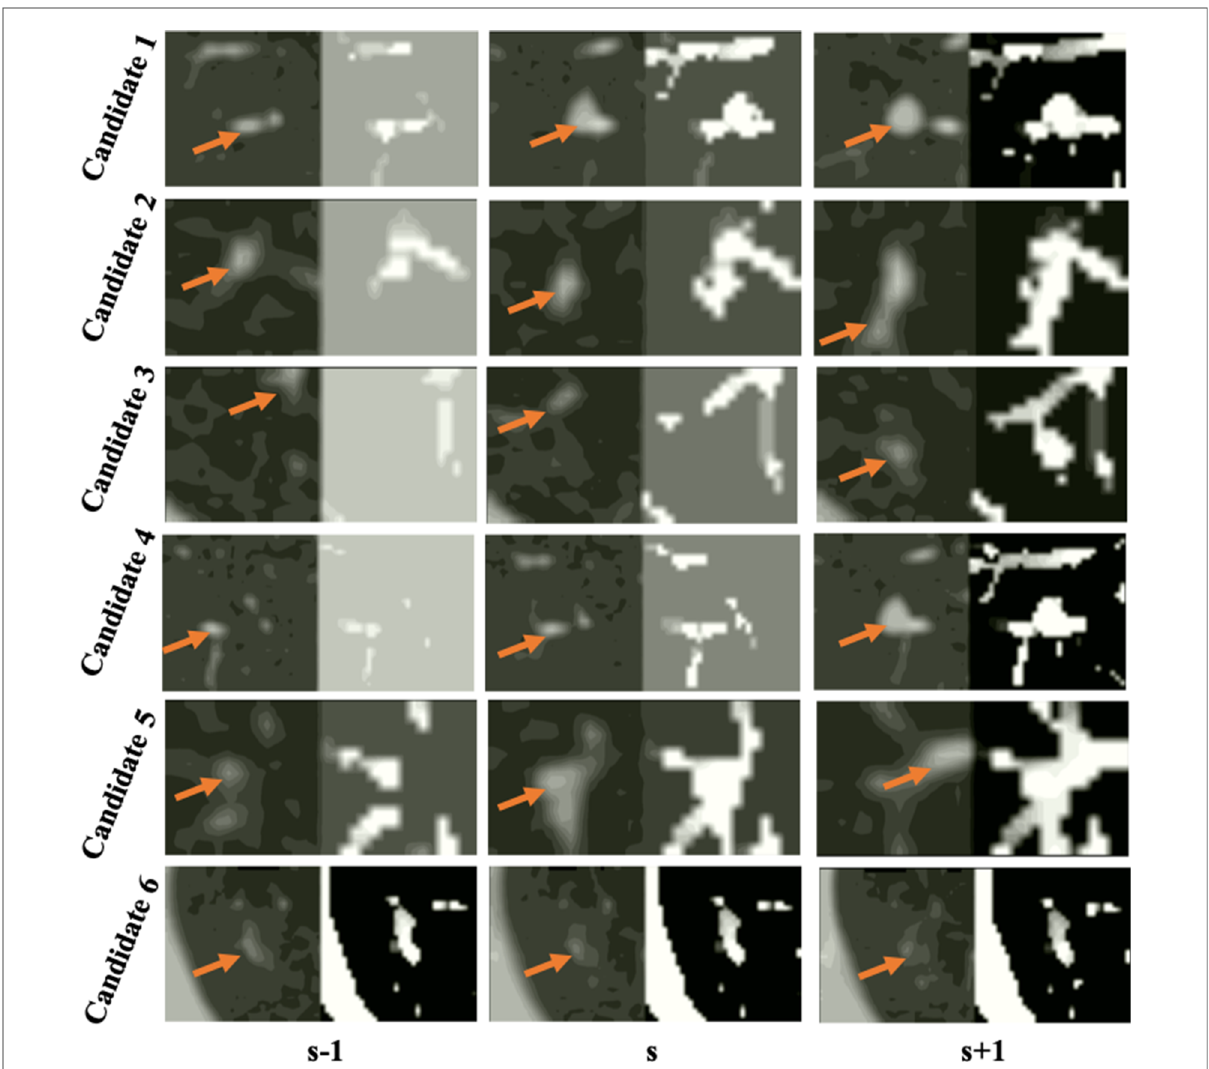
FIGURE 6 Examples of false detected tissue candidates (the left image of each column) and their corresponding LHIs (the right image of each column) calculated between three continuous slices ( s (cid:4) 2, s (cid:4) 1), ( s (cid:4) 1, s ), and ( s , s þ 1) shown in the s (cid:4) 1, s , s þ 1 columns. The orange arrows mark the position of false detected tissue candidates. LHIs of tissues are shown to have clear differences with true nodules. Compared with the LHIs of the true nodules in Figure 5 , the wide variation of tissue location follows certain patterns, illustrated as intensity variances along the trajectory lines in the LHIs.